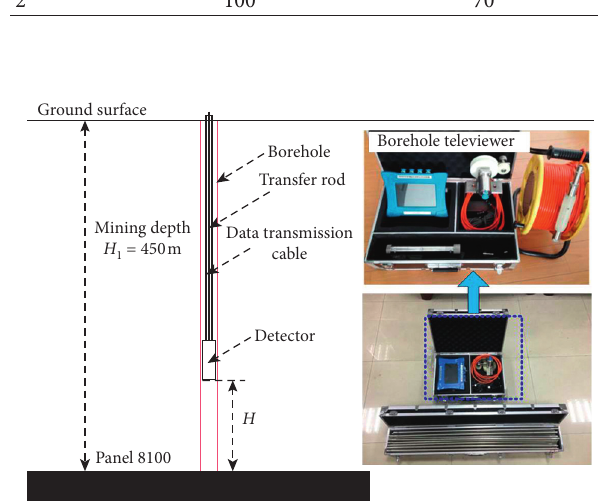
Figure 5: Borehole televiewer survey for roof